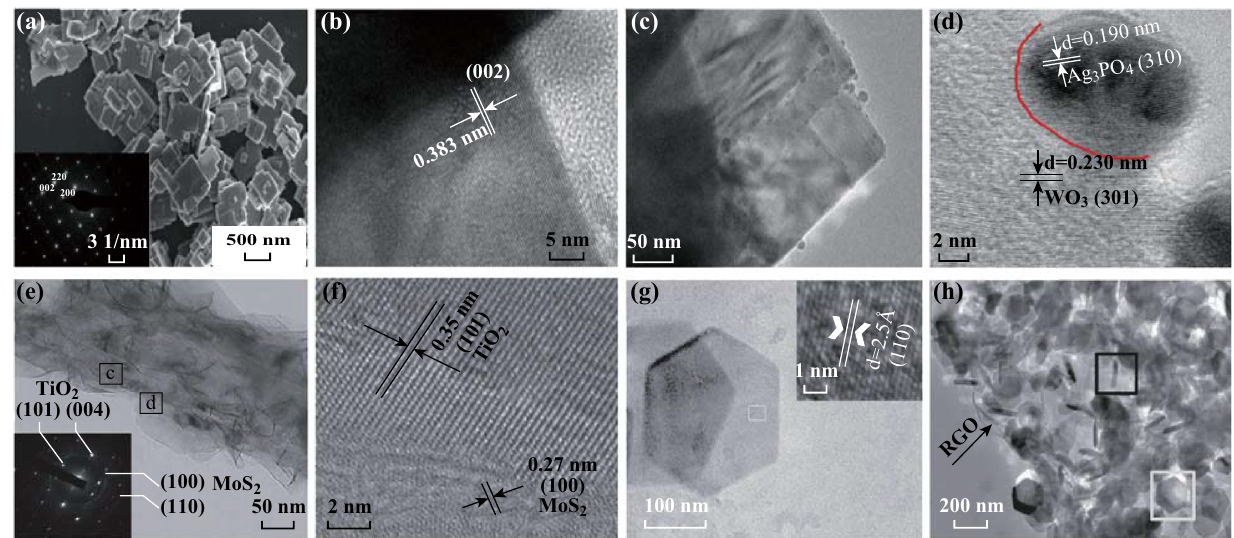
Fig. 8 Representative low- and high-resolution transmission electron microscopic images of a, b 2D-doped TMO&C nanosheets, c, d 2D–0D heterojunctions, e, f 2D–1D heterojunctions and g, h 2D–2D heterojunctions. Reproduced with permission from Ref. [56, 98, 122,